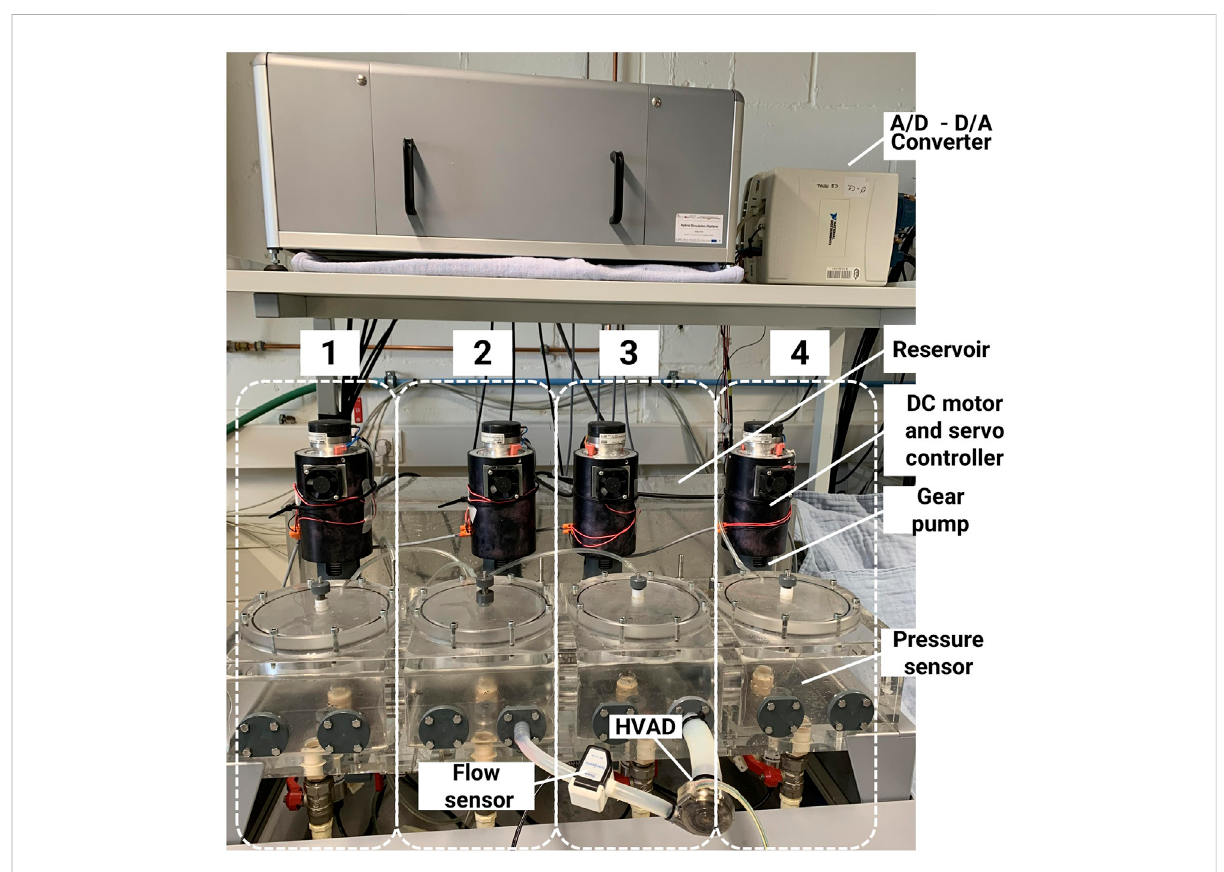
FIGURE 3 Hydraulic interface of the hybrid simulator. The system includes four hydraulic chambers, each actuated by a gear pump and a DC motor. The HVAD is connected between two chambers, one representing the left ventricle and the other the